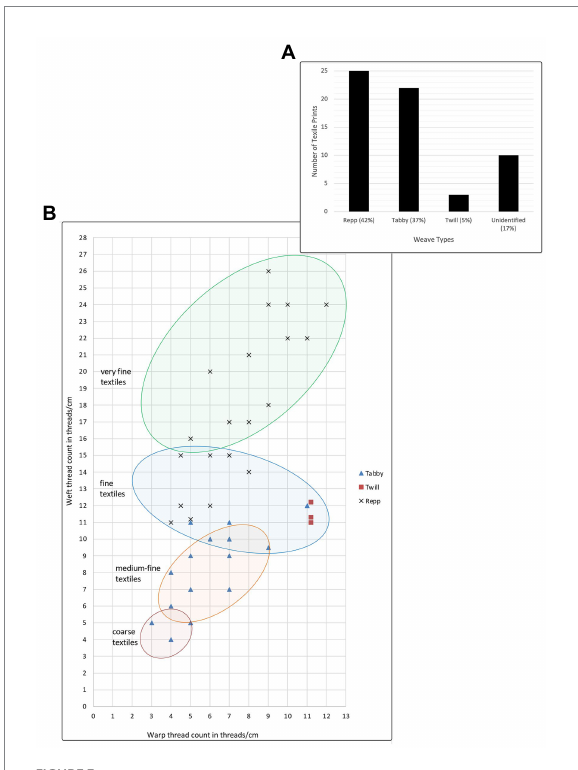
FIGURE 3 ( A , top right) Bar chart showing percentages of counts of the different weaves from Chap 1. ( B , bottom left) Thread counts for the different weave types recorded at Chap 1. Ellipses group the coarse, medium-fine, fine, and very-fine textile structures based on element counts/cm (after Grömer, 2016: Fig.